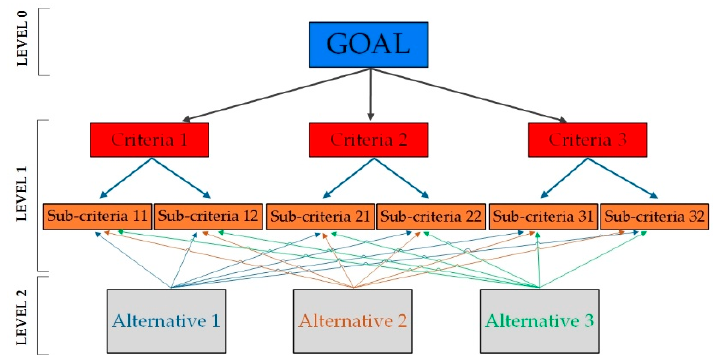
Figure 2. The schematic display of the structure of the analytical hierarchy process (AHP) method.